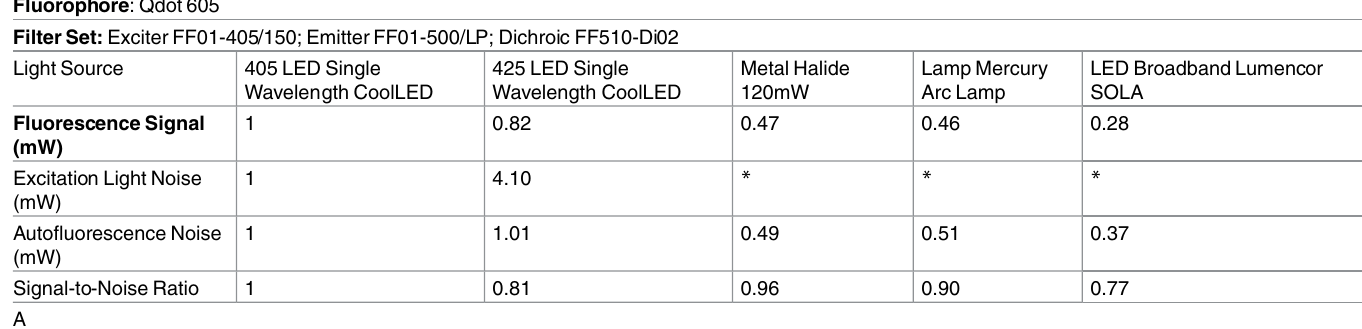
Table 2. Comparison of theoretical fluorescence parameters usingsemrocksearchlight.com;example of Qdot605. Fluorophore : Qdot